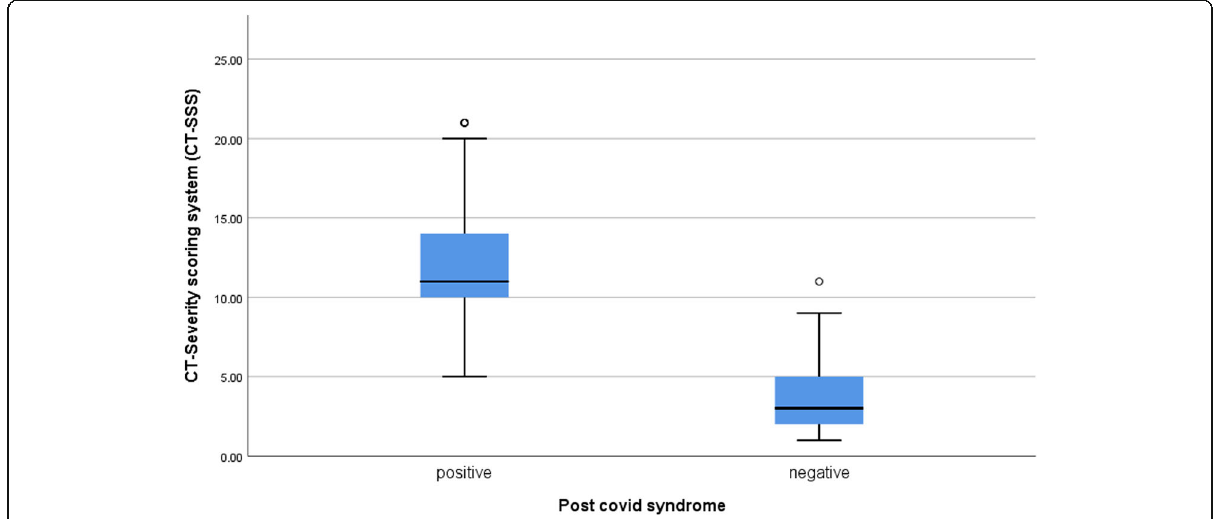
Fig. 3 Correlation between CT-SSS and development of post-COVID